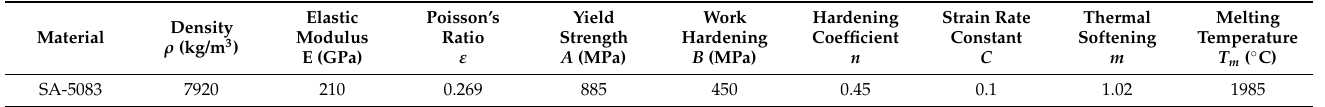
Table 2. J–C constitutive model parameters of workpiece